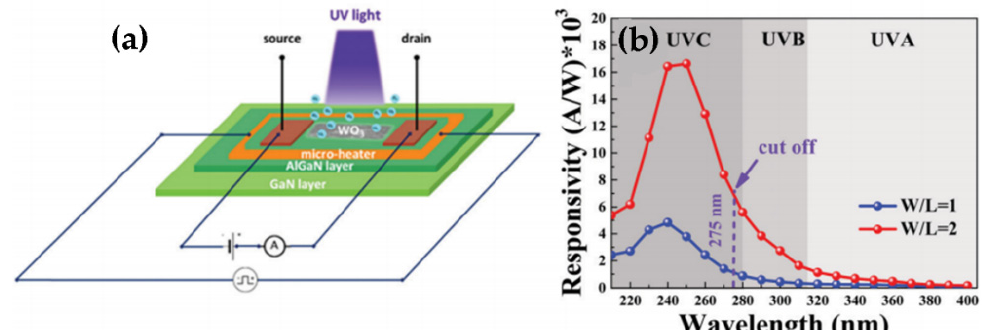
Figure 4. ( a ) Schematic illustration of the WO 3 /AlGaN/GaN heterostructure photodetector with an integrated micro − heater. ( b ) Measured spectral response of the WO 3 /AlGaN/GaN heterostructure photodetector. Reproduced or adapted from [11].